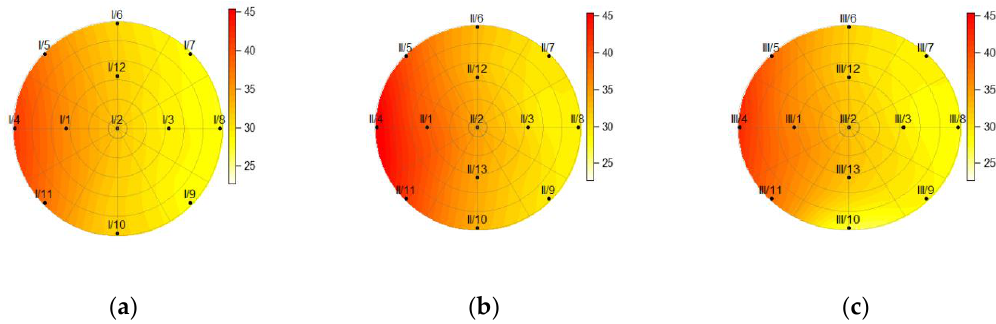
Figure 12. The temperature within the pillar, at a height of ( a ) 150 mm; ( b ) 750 mm; ( c ) and 1350 mm, 5.7 h after the heat source was turned on (before it was turned off).